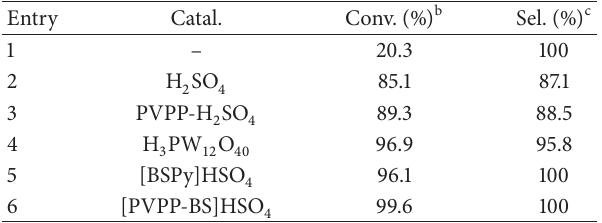
Figure 3: Thermogravimetric curves of (a) PVPP, (b) PVPP-BS, and (c) [ PVPP-BS ] HSO 4 .